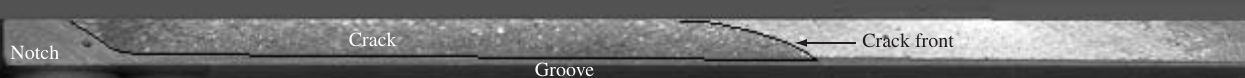
Notch Figure 2. Crack profile of a specimen tested under double-torsion. A black line highlights the crack border.